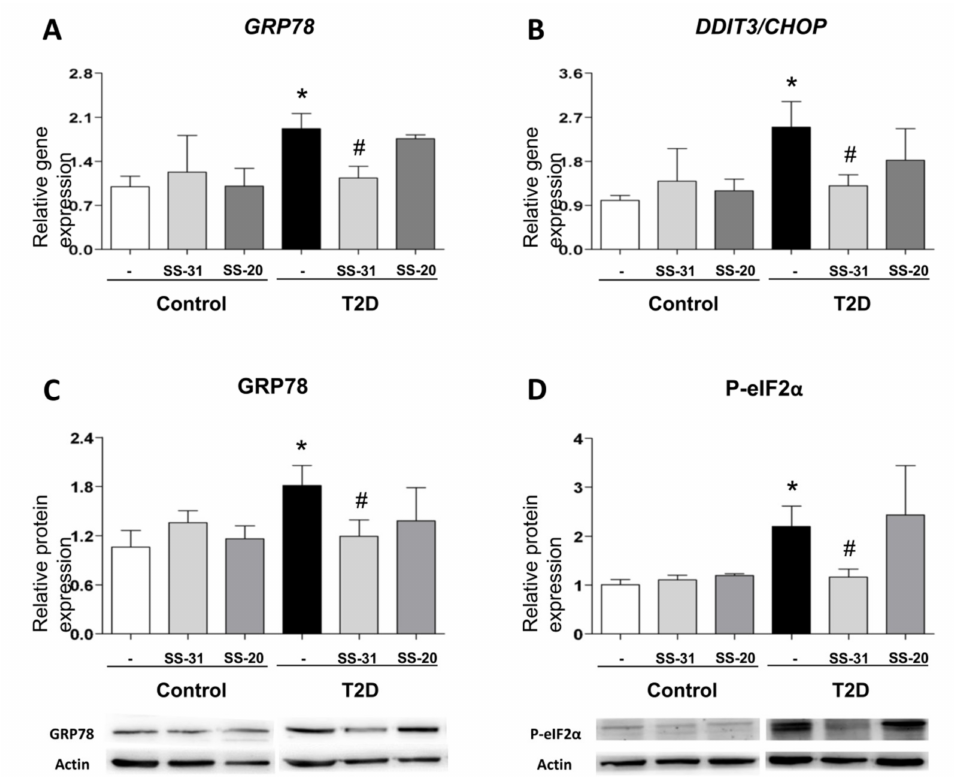
Figure 2. Evaluation of endoplasmic reticulum (ER) stress parameters in leukocytes from T2D patients and controls in the absence and presence of SS-31 (30 min, 100 nM) ( A ) GRP78 expression. ( B ) DDIT3 / CHOP expression. ( C ) GRP78 protein levels and representative western blotting (WB) images. ( D ) P-eIF2 α protein levels and representative WB images. * p < 0.05 with regard to control group # p < 0.05 vs. non-treated T2D